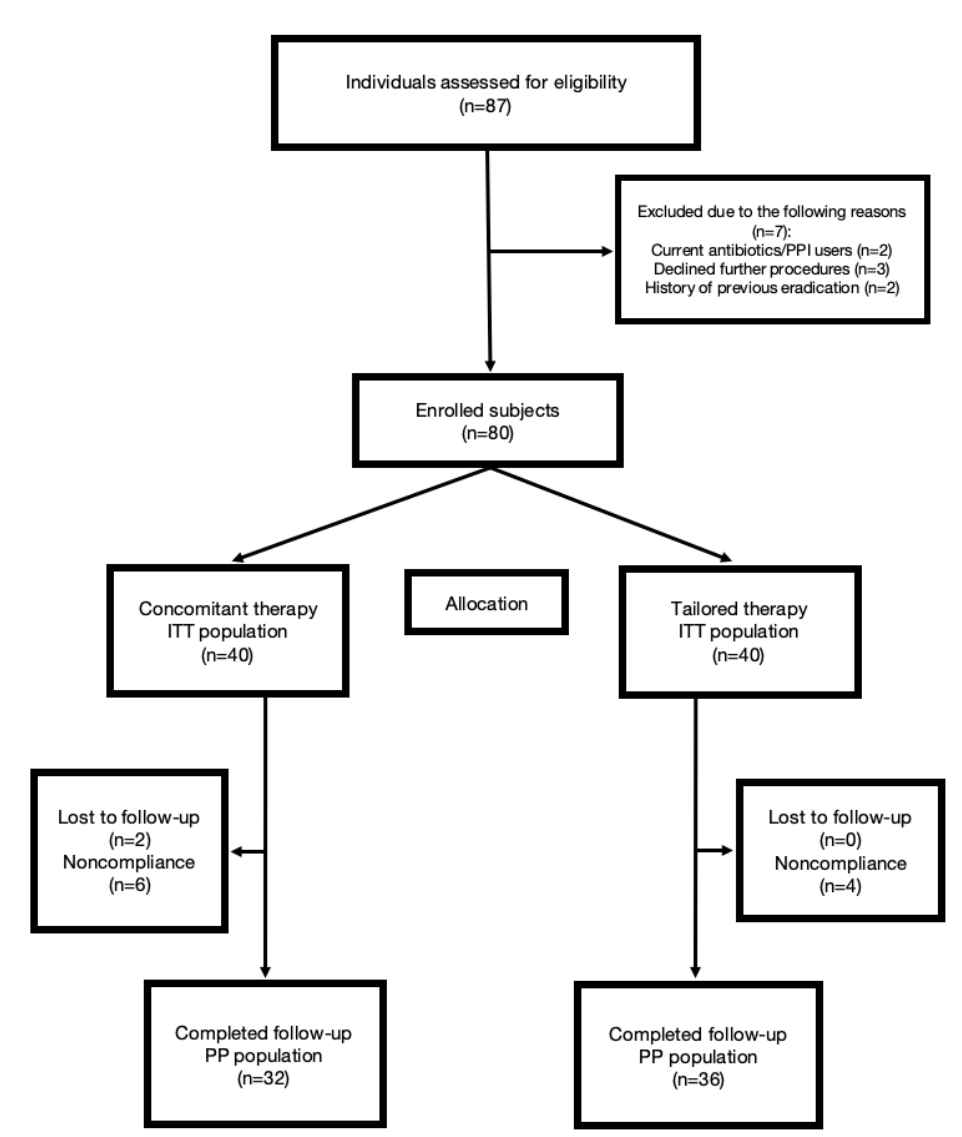
Figure 1. Study flowchart. PPI: proton pump inhibitors; ITT: intention-to-treat; PP: per-protocol.